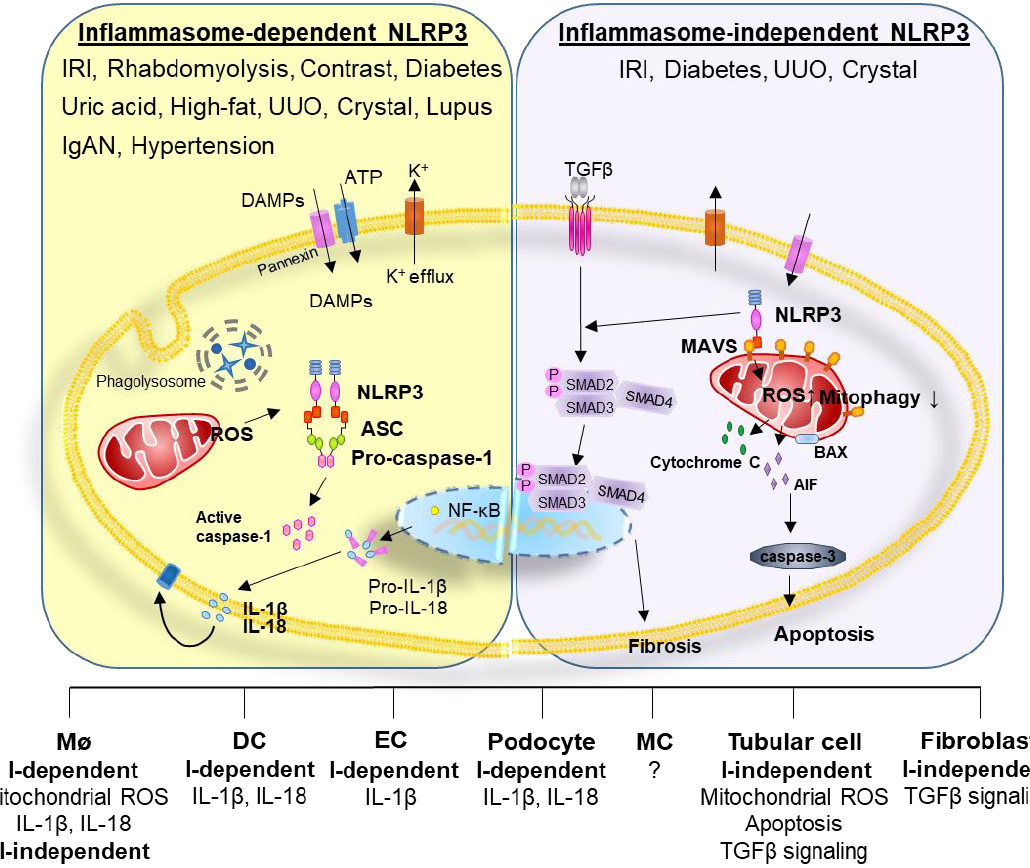
Figure 1. NLRP3 in the kidney operates in an inflammasome-dependent or inflammasome-independent manner, depending on the DAMPs and stimulated cells involved. The NLRP3 inflammasome is activated in various renal diseases in renal RMNCs and non-immune cells. Additionally, NLRP3 could regulate macrophage polarization via an inflammasome-independent way. NLRP3 leads to the generation of mitochondrial ROS and tubulointerstitial fibrosis in renal TECs. NLRP3 in renal fibroblasts is implicated in mediating renal fibrosis. AIF = apoptosis-inducing factor, BAX = bcl-2-like protein 4, DAMPs = damage-associated molecular patterns, DC = dendritic cell, EC = endothelial cell, IgAN = IgA nephropathy, IRI = ischemic reperfusion injury, I-dependent = inflammasome-dependent, I-independent = inflammasome-independent, M Φ = macrophage, MC = mesangial cell, NF- κ B = nuclear factor kappa-light-chain-enhancer of activated B cells, ROS = reactive oxygen species, UUO = unilateral ureteral obstruction.